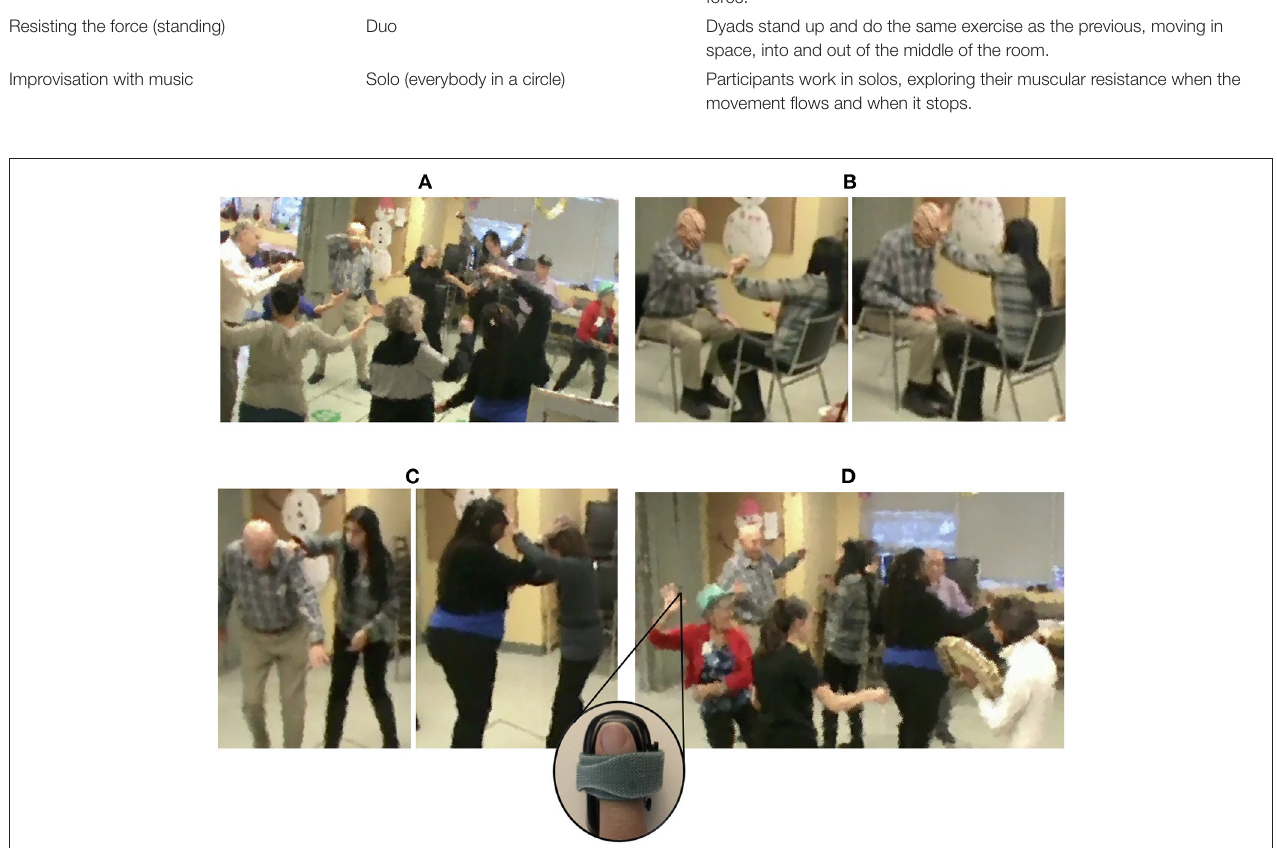
FIGURE 1 | Different activities comprising the movement session: (A) Solo activity: musical textures. (B) Duo activity: Resisting the force (sitting). (C) Duo activity: Resisting the force (standing). (D) Solo activity: Improvisation with music.